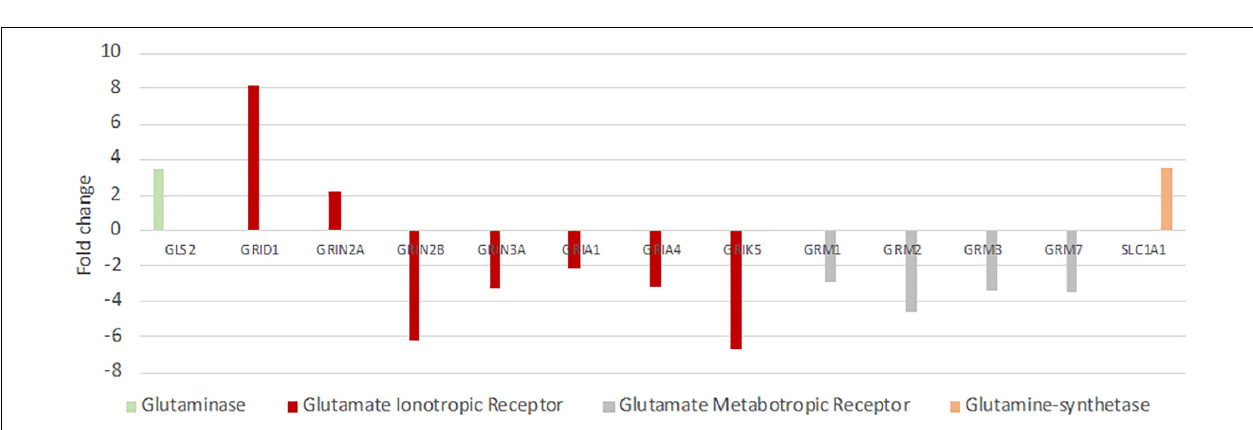
FIGURE 5 | Differential expression of genes playing key roles in glutamatergic synaptic transmission and the glutamine-glutamate-cycle in hooded seals compared to neurons of mice. Positive fold changes represent a higher expression in seal neurons.